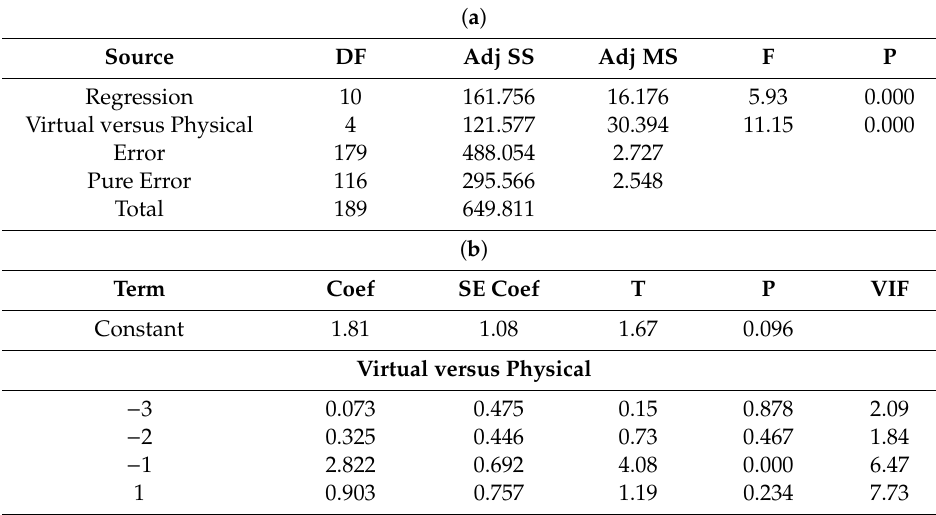
Table 8. ( a ) ANOVA for the valence construct of the cleaning task with di ff erent feedbacks. ( b ) Multiple comparisons of the valence construct for integrated feedback.